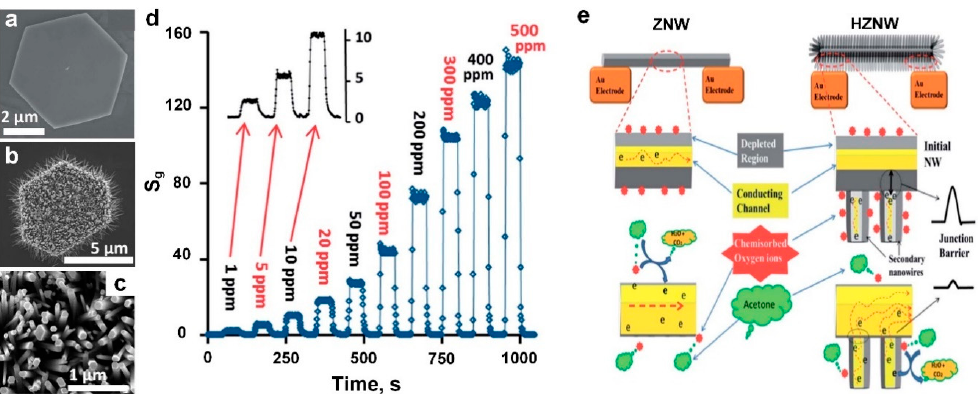
Figure 11. SEM image of single ( a ) ZND, ( b ) HZND, and ( c ) the secondary NWs. ( d ) Response vs. time curve of the HZND sensor in the range of 1 to 500 ppm under the optimum conditions of 425 °C. ( e ) A schematic diagram of the sensing mechanism of ZnO NW vs. hierarchical nanostructures: charge transport in single NW (left) and the effect of the secondary NW–initial nanostructure junctions (right) on the charge transport in the hierarchical nanostructures [21].